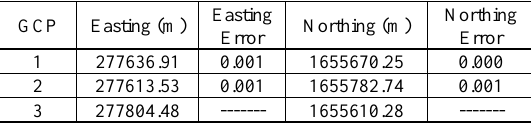
Table 3. Adjusted GCP grid coordinates